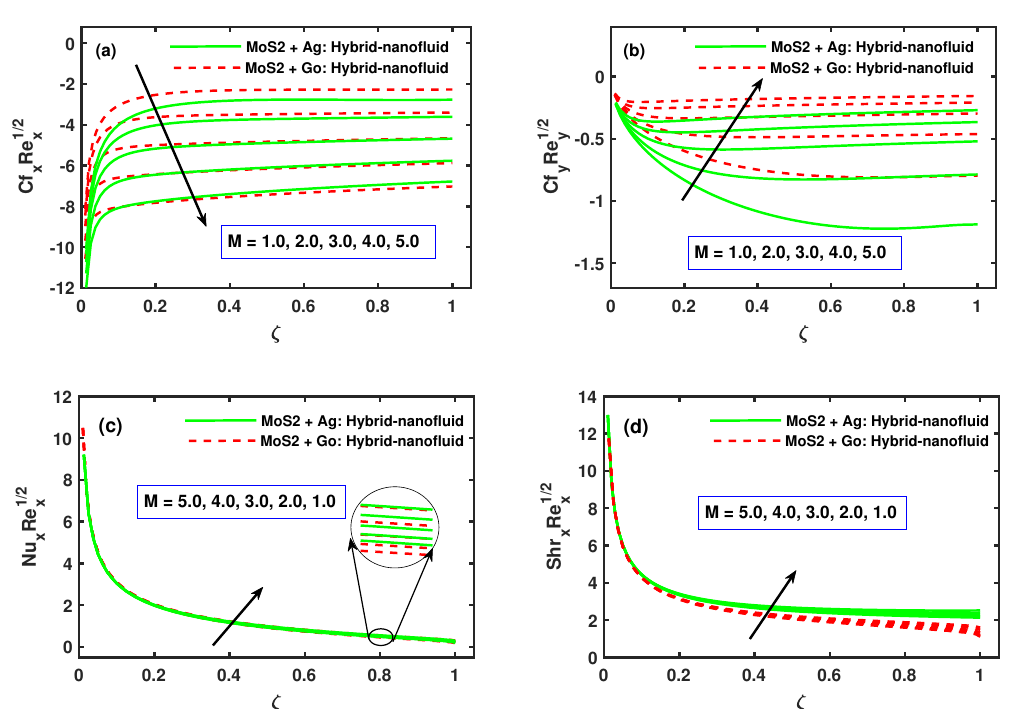
Figure 11. Fluctuation of Cf x Re 1/2 x , Cf y Re 1/2 y , Nu x Re 1/2 x , and Sh x Re 1/2 x along with M (magnetic